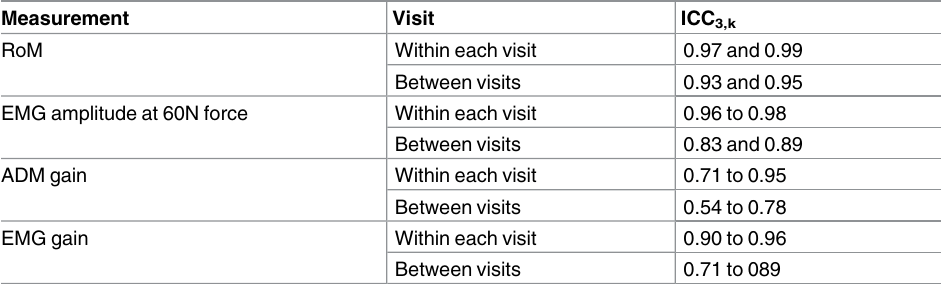
Table 1. Reliability results within sessions (at each visit) between control and pre-exposure test, and between test sessions for the control and pre-exposure tests. Measurement Visit ICC 3,k RoM Within each visit 0.97 and 0.99 Between visits 0.93 and 0.95 EMG amplitude at 60N force Within each visit 0.96 to 0.98 Between visits 0.83 and 0.89 ADM gain Within each visit 0.71 to 0.95 Between visits 0.54 to 0.78 EMG gain Within each visit 0.90 to 0.96 Between visits 0.71 to 089 ICC 3,k = Intraclass correlation coefficient averaged measures calculated using a two way mixed model; For the admittance gain (ADM gain) and reflex gain (EMG gain) the reliability was separately calculated for each of the five input frequencies